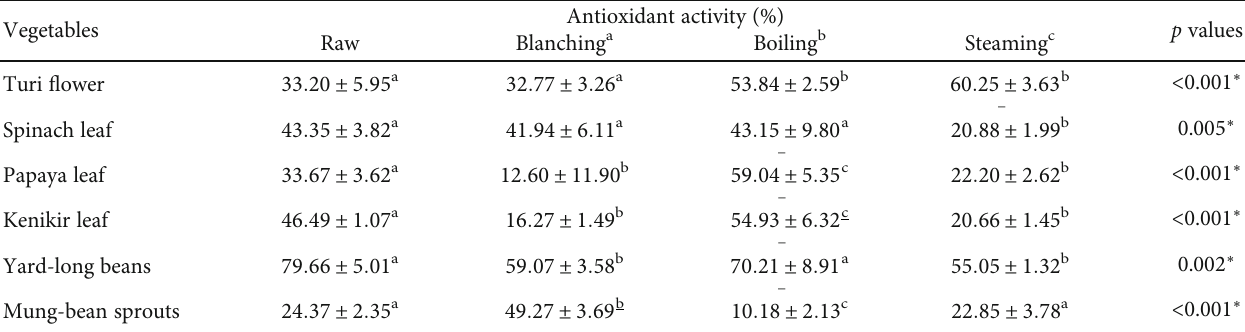
Table 2: E ff ect of cooking methods on antioxidant activity of Pecel